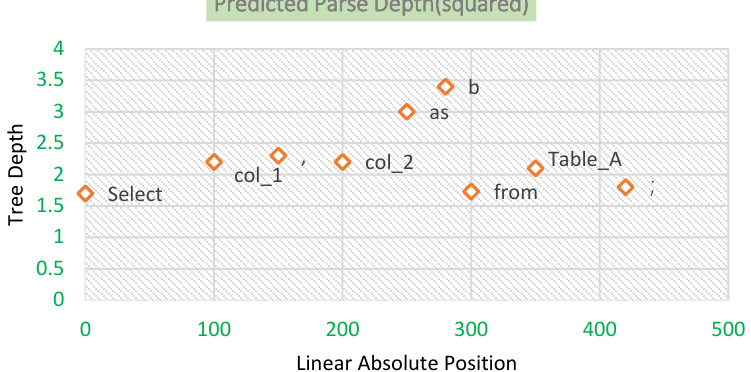
Figure 6. Predicted parse depth. The horizontal coordinate is the position of the word in the SQL statement, and the vertical coordinate is the depth (relative value) of the word in the syntax tree learned by the model. It can be seen that the depth of the syntax tree computed by the synBERT model is similar to the actual value.